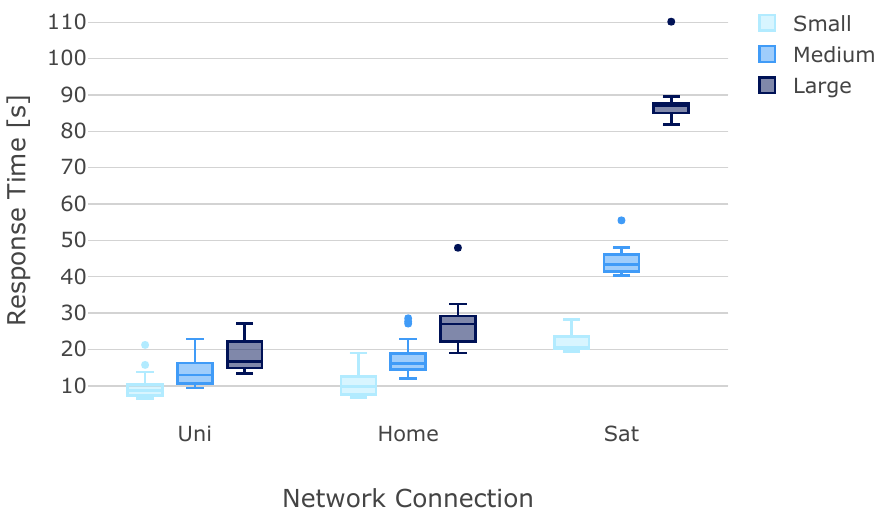
Figure 12. Response time using the UNI, HOME and SAT network connections, in case of locally hosted video files, with different sizes (small, medium and